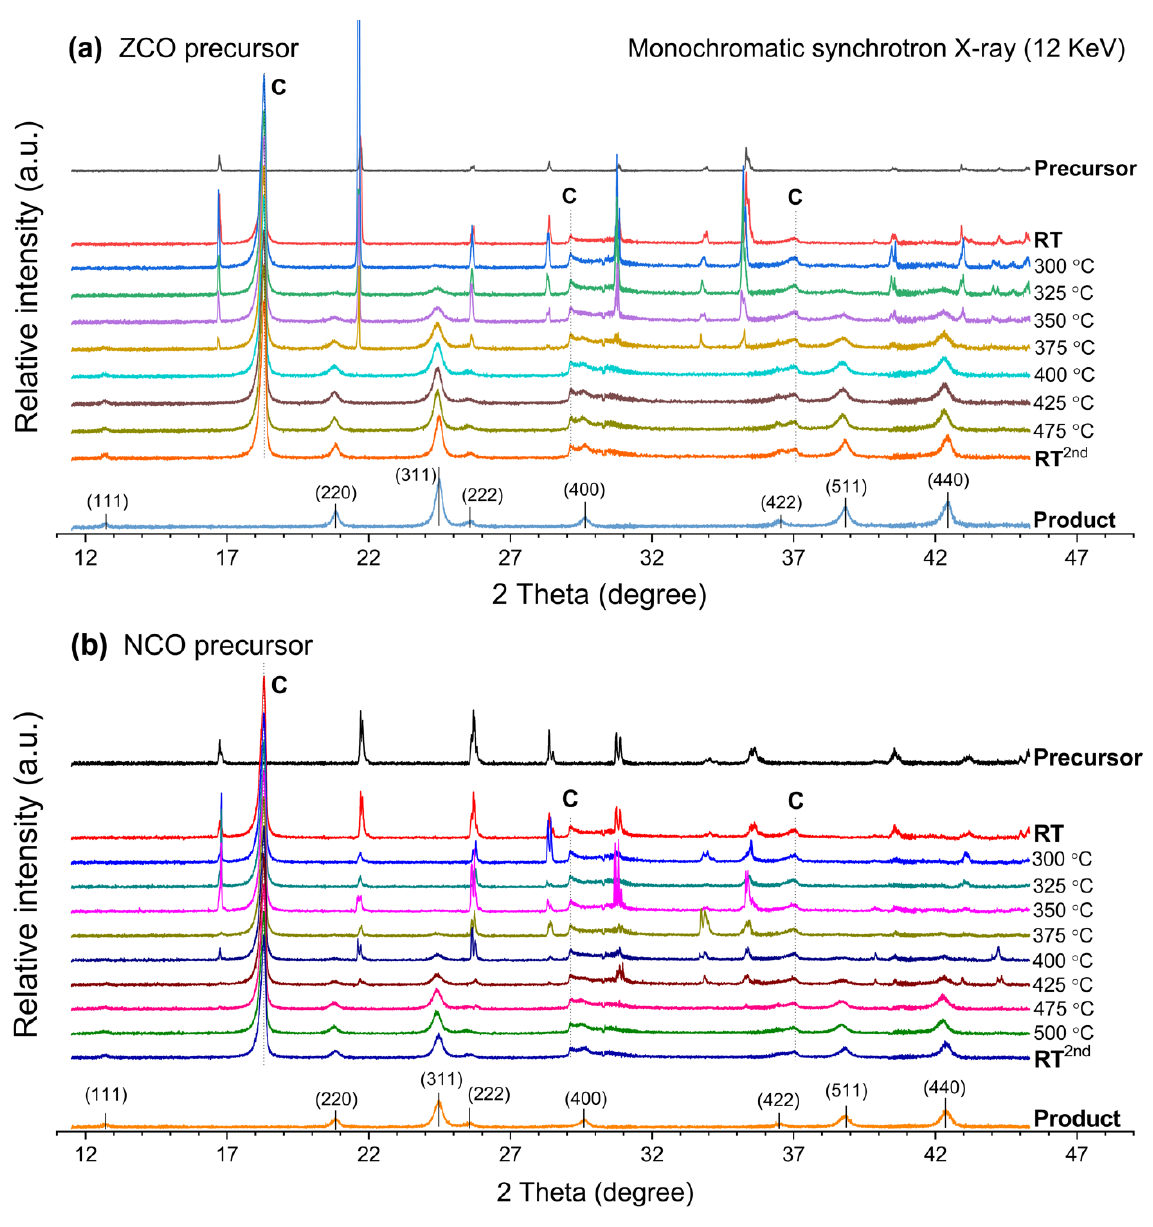
Figure 3. In-situ XRD profile represents phase transformation of the ( a ) ZCO precursor and ( b ) NCO precursor upon an elevating calcination temperature. (C = graphite dome).